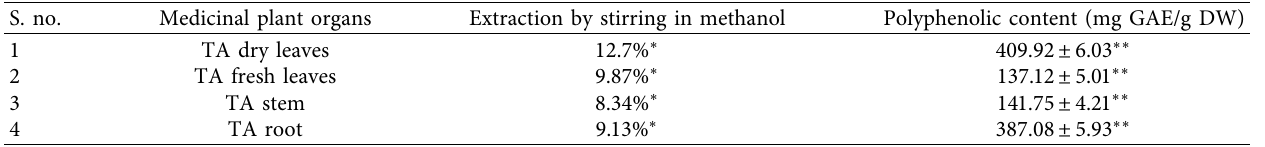
Table 2: Type of extraction used for extraction from medicinal plant TA and its yield (g/100g of DW of powder) and total polyphenolic content of different parts of